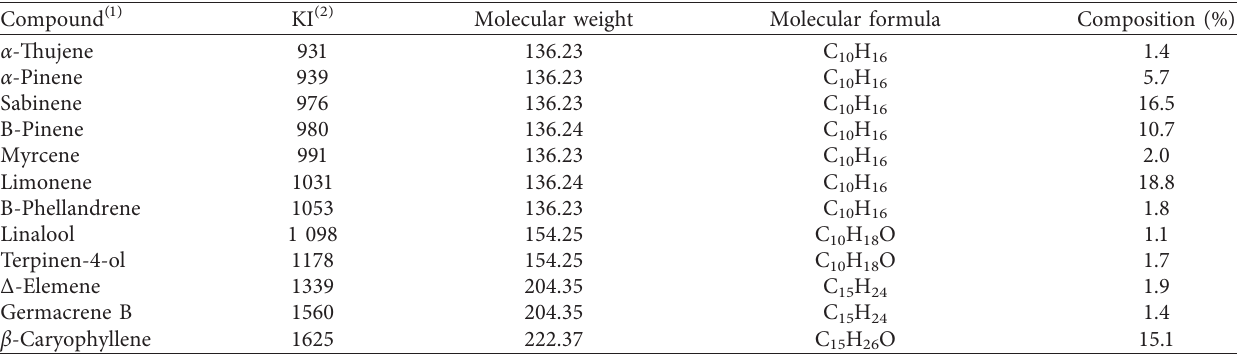
Table 2: Chemical composition of pepper ( Piper nigrum ) essential